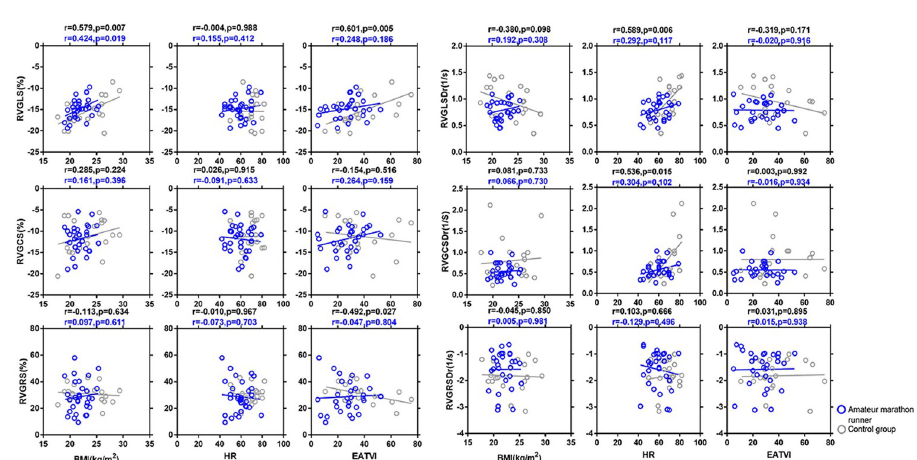
Fig 4. Simple correlations between the cardiac magnetic resonance parameters of right ventricular global radial strain (RVGRS), right ventricular global circumferential strain (RVGCS), right ventricular global longitudinal strain (RVGLS), right ventricular global radial strain of diastolic rate (RVGRSDr), right ventricular global circumferential strain of diastolic rate (RVGCSDr), and right ventricular global longitudinal strain of diastolic rate (RVGLSDr), respectively with body mass index (BMI), heart rate (HR), and epicardial adipose tissue volume index (EATVI) in the amateur marathon runners and control group. A simple regression analysis was made separately in amateur marathon runners (blue circles and lines) and control group (black circles and lines). The R and P-values are shown. RVGRS,right ventricular global radial strain; RVGCS, right ventricular global circumferential strain; RVGLS, right ventricular global longitudinal strain; RVGRSDr, right ventricular global radial strain of diastolic rate; RVGCSDr, right ventricular global circumferential strain of diastolic rate; RVGLSDr, right ventricular global longitudinal strain of diastolic rate; BMI, body mass index; HR, heart rate; EATVI, epicardial adipose tissue volume index.